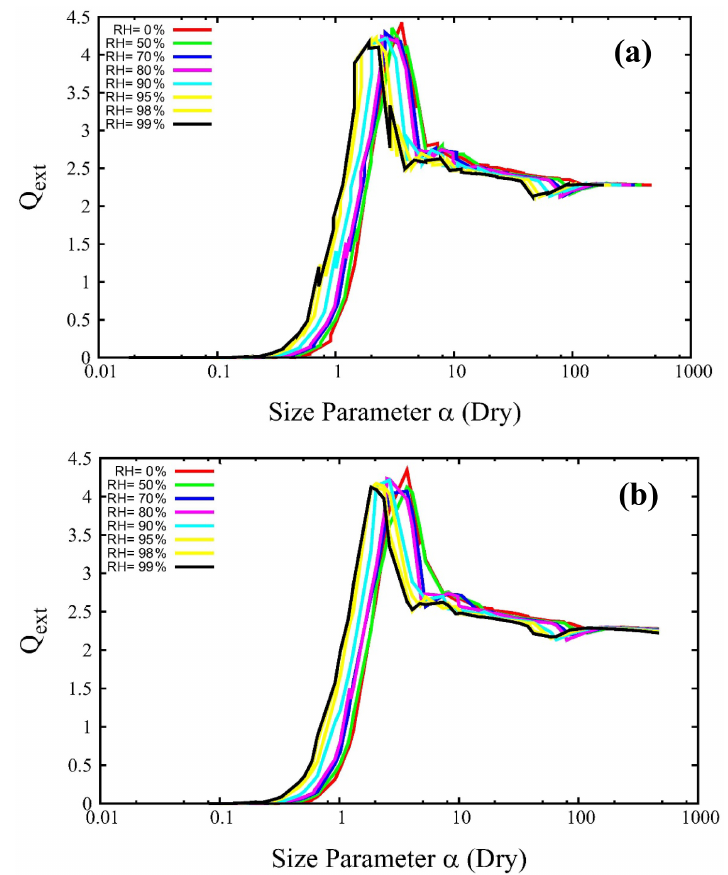
Figure 2. (a) Initial and (b) interpolated Q ext (extinction efficiency) vs. dry α (size parameter) for ammonium sulfate.